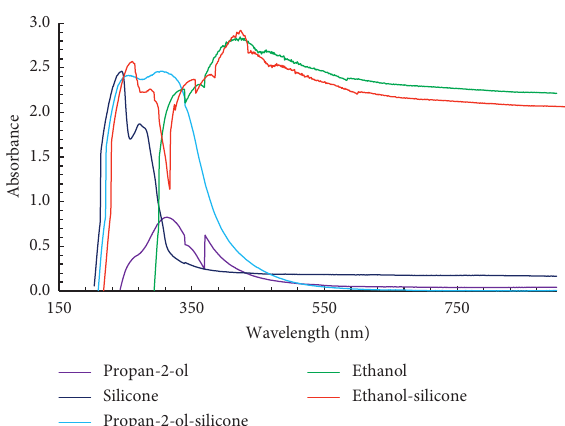
Figure 3: Spectrum of ultraviolet absorption of extracts of apricot cake.